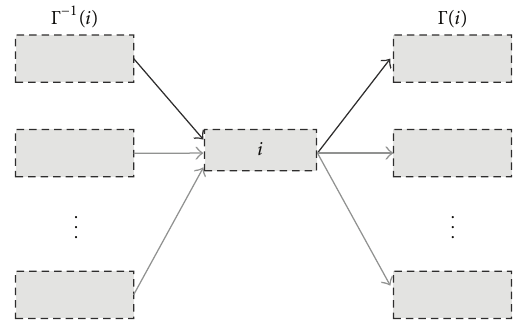
Figure 5: Generalized extended CTM on